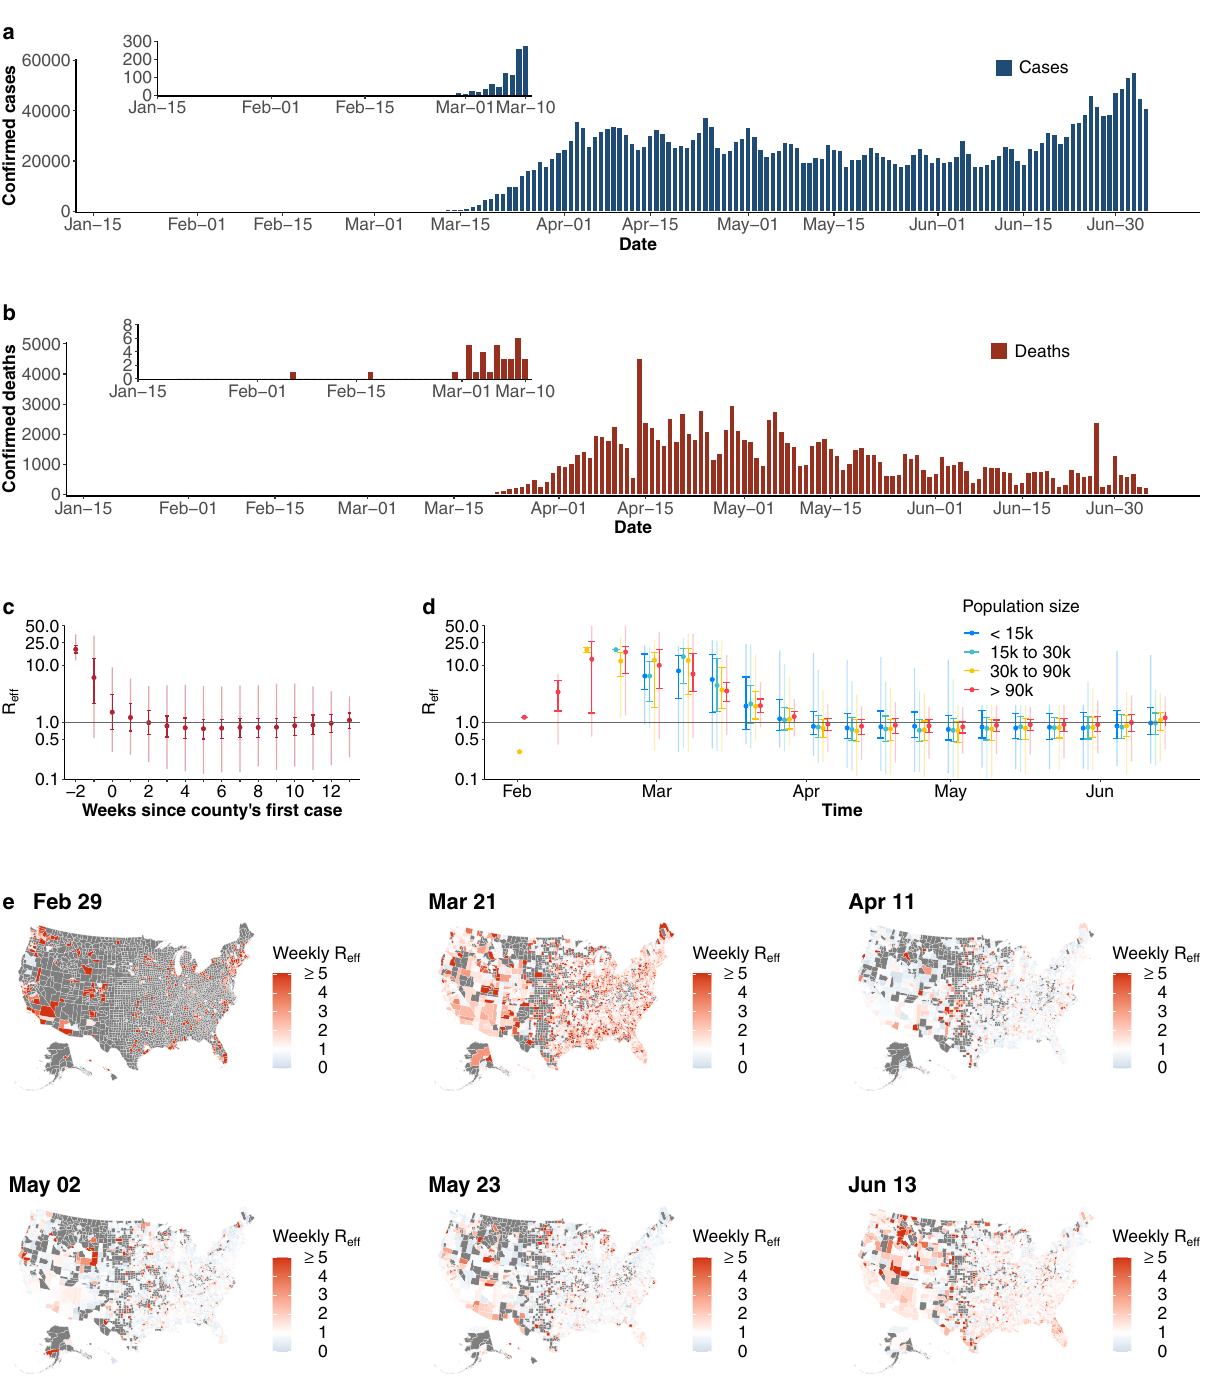
Fig. 1 Con fi rmed COVID-19 cases and reproduction numbers ( R eff ) in the United States. a Daily con fi rmed COVID-19 cases. b Daily con fi rmed COVID-19 deaths. c Distribution of R eff by weeks since the county ’ s fi rst reported case ( n = 36,737 county-weeks). Gray horizontal line indicates the threshold of R = 1 (same as in c ). Medians (points), interquartiles (dark vertical lines) and 95% percentiles (light vertical lines) are shown (same as in d ). d Temporal eff distribution of R eff strati fi ed by county population size. County population size was classi fi ed into four groups, i.e., <15,000 (blue, n = 7656 county-weeks), 15,000 – 30,000 (green, n = 8139 county-weeks), 30,000 – 90,000 (orange, n = 10,929 county-weeks) and >90,000 (red, n = 10,013 county-weeks). e Map of county R eff for representative weeks. Weeks were selected with a 3-week interval from the last week when R e ff were available. Gray indicates no data Univariate and multivariate models for each NPI showed each NPI one at a time. The largest changes in estimated coef fi - similar relative associations (Supplementary Fig. 10) as did cients were seen when dropping school closure, which sub- models that included an effect for time since the fi rst case or fi rst stantially impacted the estimated association of R eff with 10 cases in a county (Supplementary Figs. 11, 12). To assess the remaining coef fi cients (e.g., the coef fi cient of banning nursing impact of collinearities, we reran the main model holding out home visits indicated a 6.5% larger reduction in models without